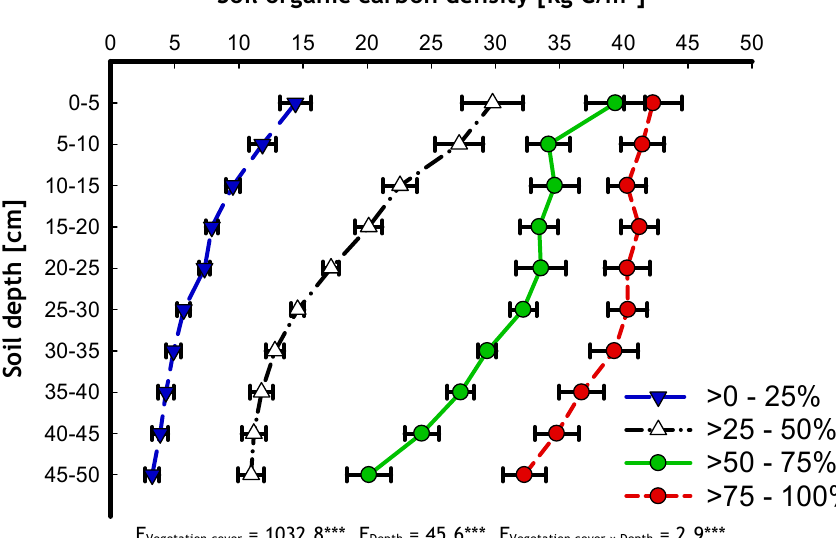
Figure 5. Distribution of soil organic carbon density [kg C/m 3 ] in relation to soil depth [cm] in ten sites represent ten sabkhas with different vegetation covers along the southern Red Sea coast of Saudi Arabia. Horizontal bars indicate the standard errors of the means; F -values represent the two-way analysis of variance (ANOVA); Vegetation cover: 0—25%, >25—50%, >50—75% and >75—100%; Depth: 0—5, 5—10, 10—15, 15—20, 20—25, 25—30, 30—35, 35—40, 40—45 and 45—50 cm; ***: p < 0.001; n = 30 for vegetation cover >25—50 and >75—100%; n = 32 for vegetation cover 0—25%; n = 33 for vegetation cover >50—75%.